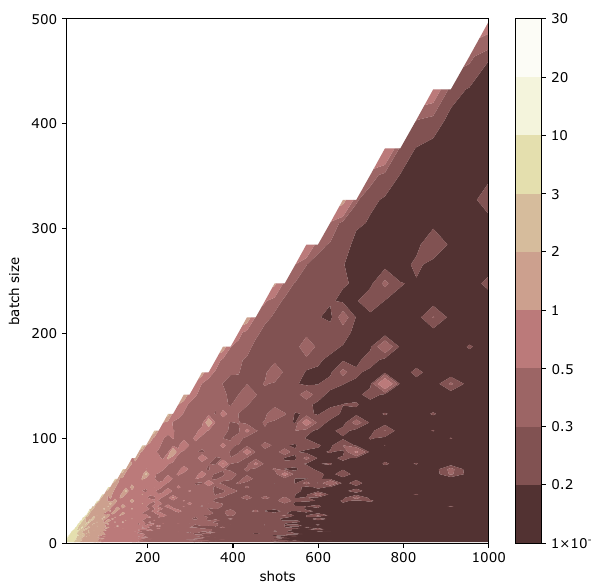
FIG. 9. Numerical simulations of batching SIC-based classi- cal shadow purities. We plot the purity’s standard deviation from 100 repetitions of each point in the 2D grid using a logarithmic color scheme. A three-qubit linear cluster state is utilized in these numerical simulations, although the particular state and qubit number does not effect the qualitative picture. Regions of similar accuracy are found to have a certain almost vertical extension, indicating that bunching does not significantly degrade accu- racy, while greatly reducing computation complexity. The ideal batch size must be evaluated on a case-by-case basis, weighing convergence against analysis time.